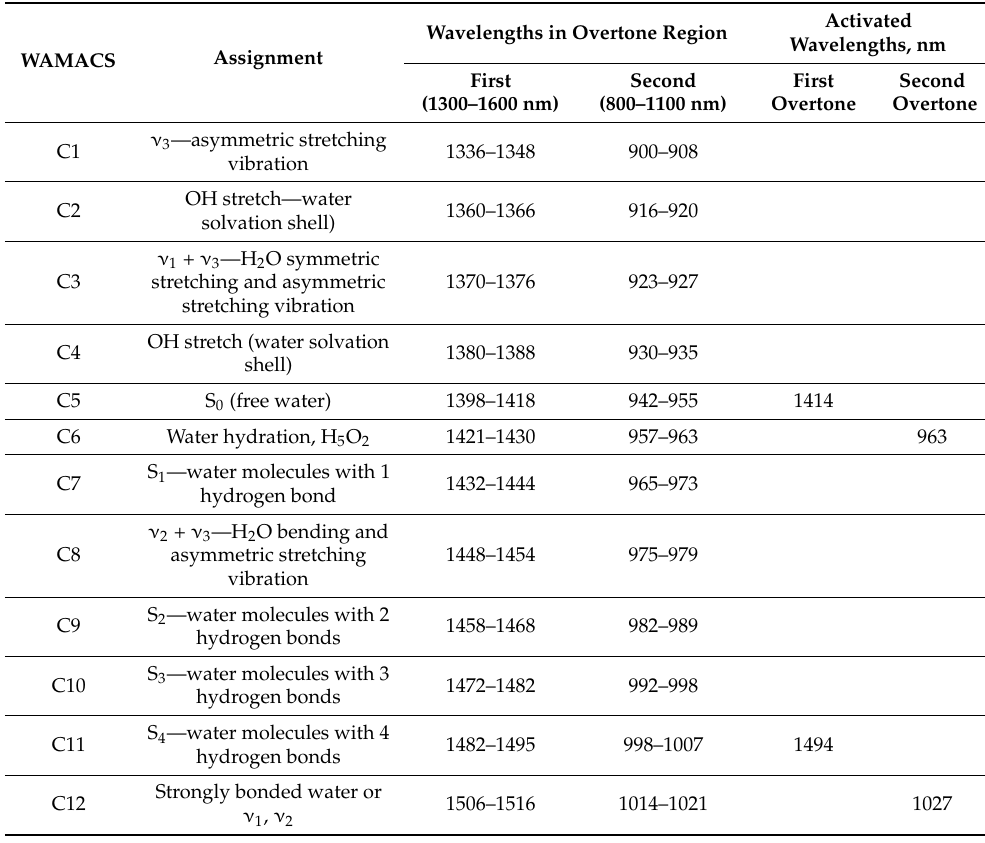
Figure 4. PC1 loading of kiwifruit juice in ( a ) the first overtone and ( b ) the second overtone region of the OH stretch of water. Labels indicate peak wavelengths (black) and zero-crossing points (red). Table 1. Temperature-perturbed water wavelengths of kiwifruit juice in the first [16,29] and the second overtone regions of OH stretch of water [30].